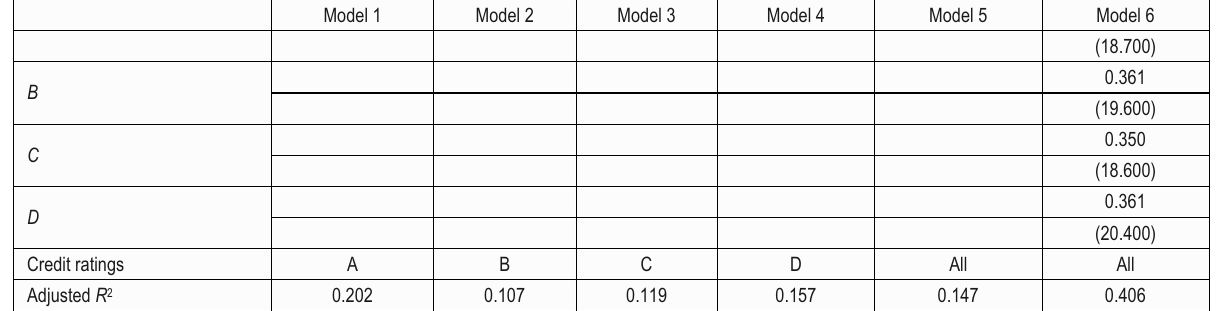
Table 6 (cont.). Multivariate analysis of cash holdings and credit rating